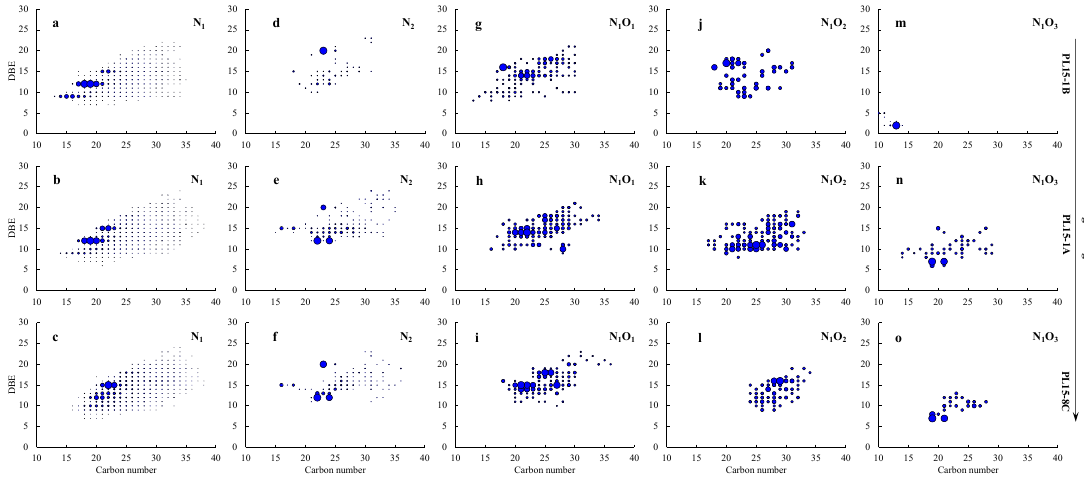
Figure 6. Iso-abundance plots of DBE versus carbon number of N 1 , N 2 and N 1 O 1 –N 1 O 3 classes in the crude oils. ( a – c ), ( d – f ), ( g – i ), ( j – l ), and ( m – o ) show the distribution of N 1 , N 2 and N 1 O 1 –N 1 O 3 classes for the PL15-1B, PL15-1A, and PL15-8C oils, respectively.